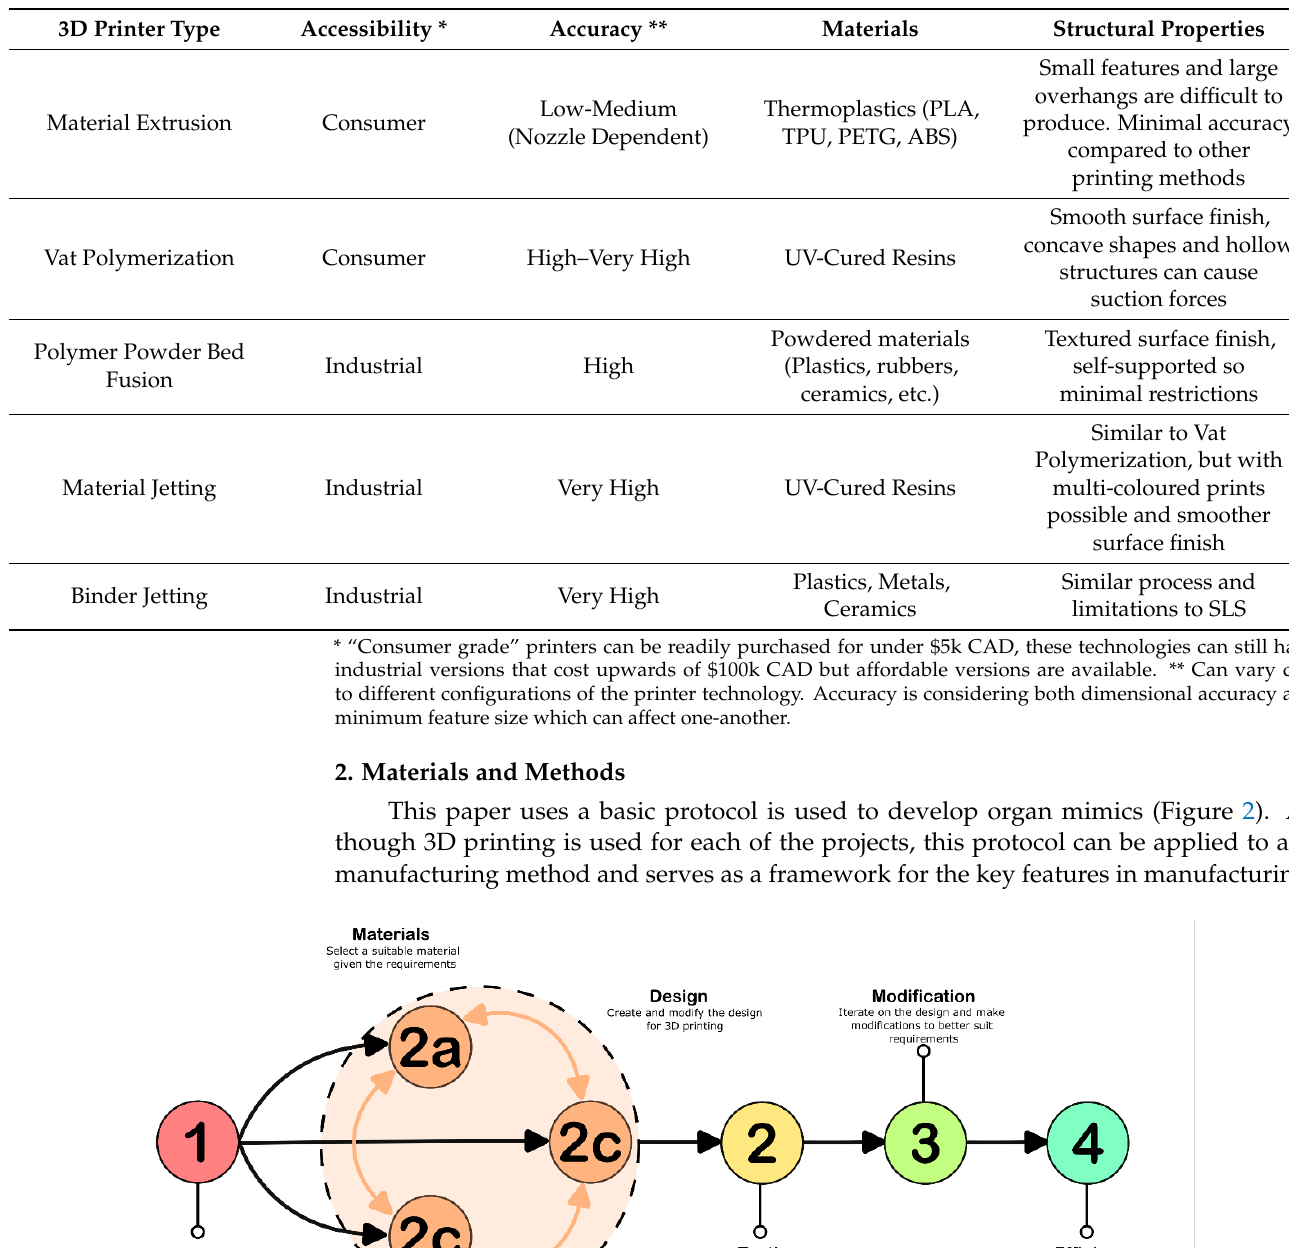
Table 1. Comparison of non-metal 3D printer